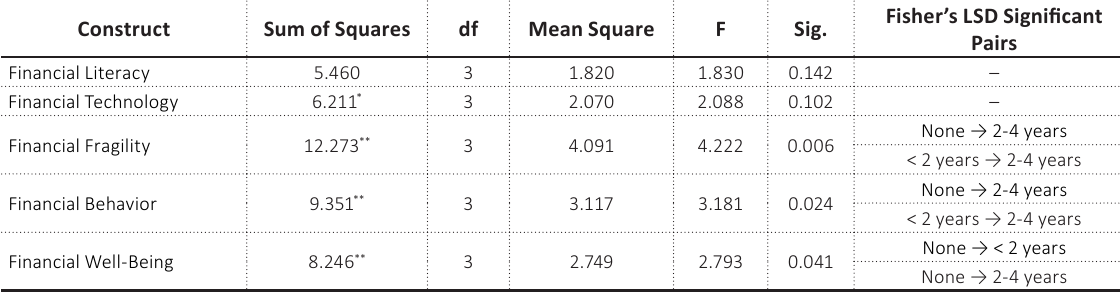
Table 12. One-way ANOVA for each factor across work experience Construct Sum of Squares